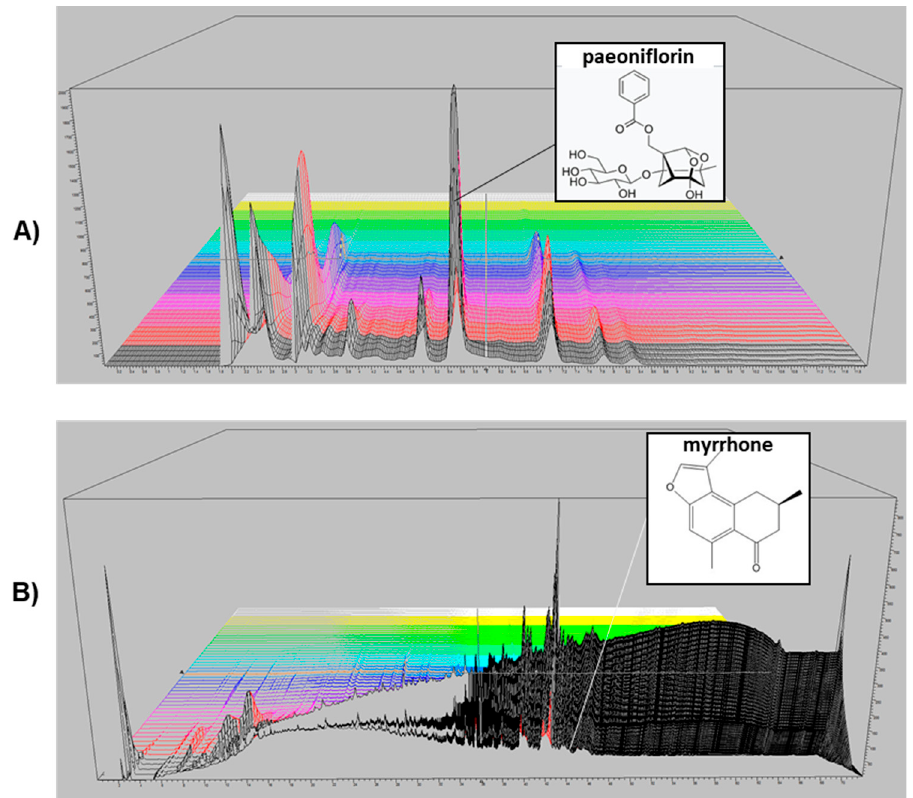
Figure 1. 3-D HPLC chromatogram of Paeonia lactiflora and Commiphora myrrha extracts. Detection was performed by using a photodiode array detector. X-axis is retention time; Y-axis is wavelength, and Z-axis is absorbance unit. Analytical conditions were as follows: column, C18 (4.6 x 250, 5 µm); mobile phase, solvent A (0.1% phosphoric acid) and solvent B (acetonitrile); flow rate, 1 mL/min; program,